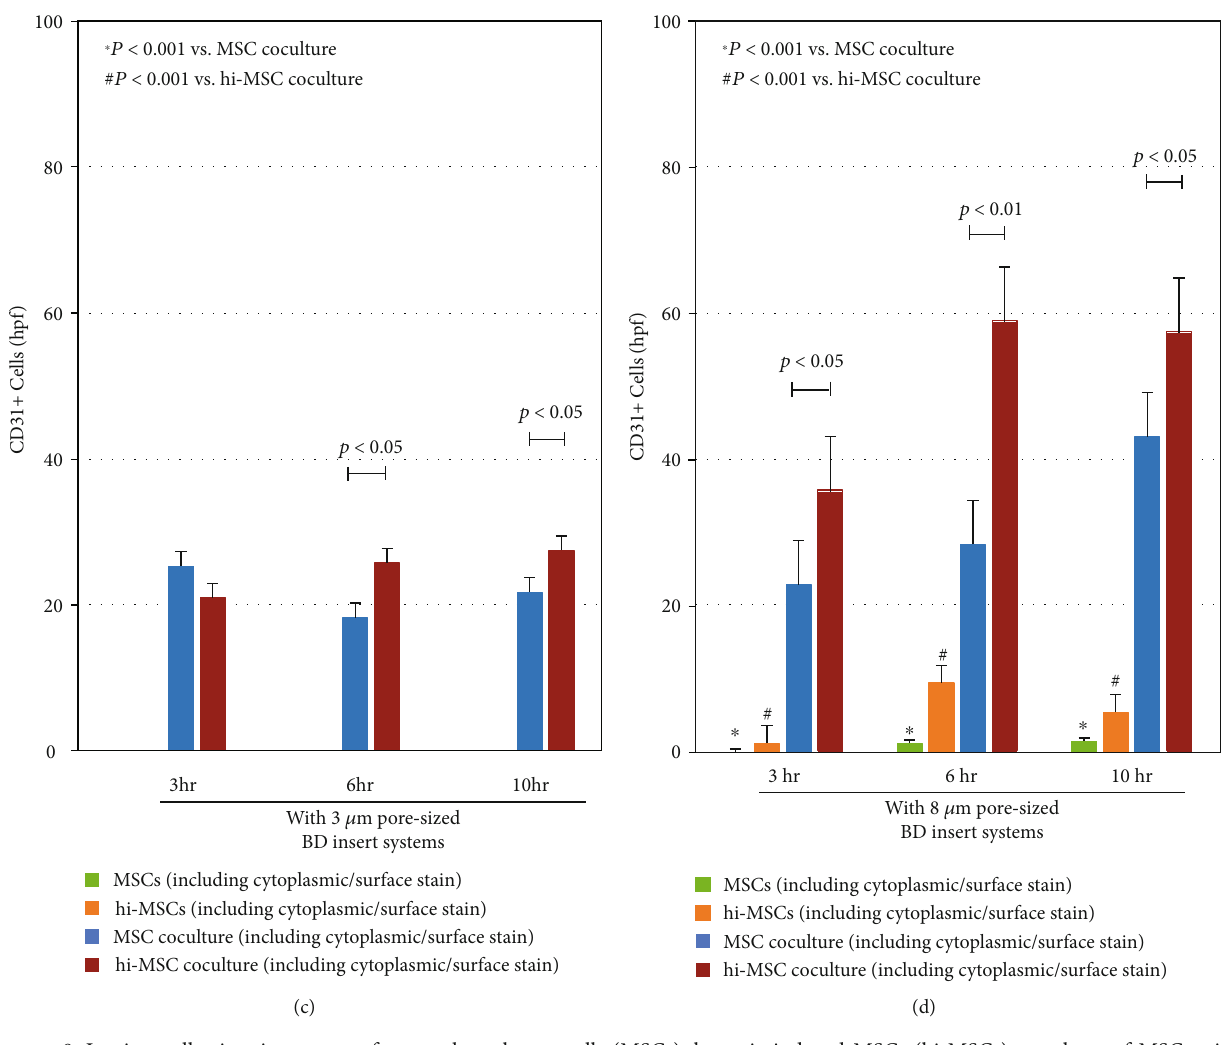
Figure 8: In vitro cell migration assays of mesenchymal stem cells (MSCs), hypoxia-induced MSCs (hi-MSCs), coculture of MSCs with human umbilical vein endothelial cells (HUVECs) (MSC coculture), and coculture of hi-MSCs with HUVECs (hi-MSC coculture) at each time point of the 3 rd hour (3 hr), 6 th hour (6 hr), and 10 th hour (10 hr) with (a, c) 3 μ m pore-sized inserts and (b, d) 8 μ m pore- sized. The hi-MSC population of cells may have added potential for coculture migration capacity compared to the MSC population of cells. Scale bar: 50 μ